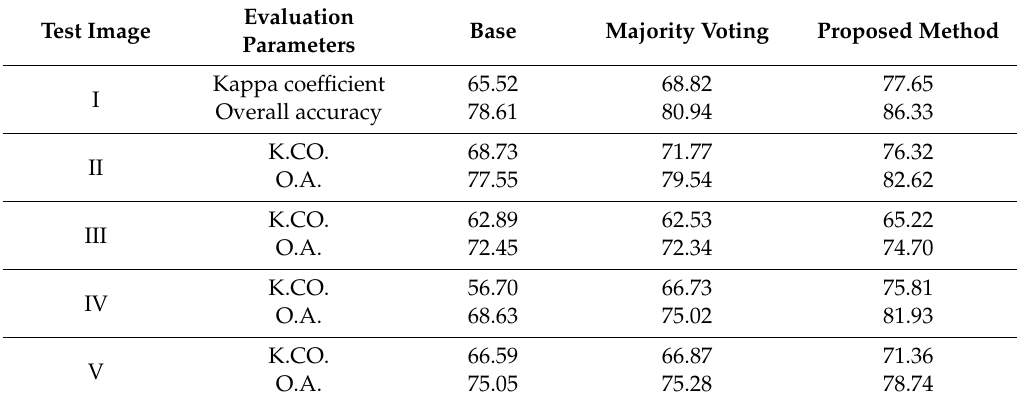
Table 1. Evaluation of the test images and internal investigation of the proposed